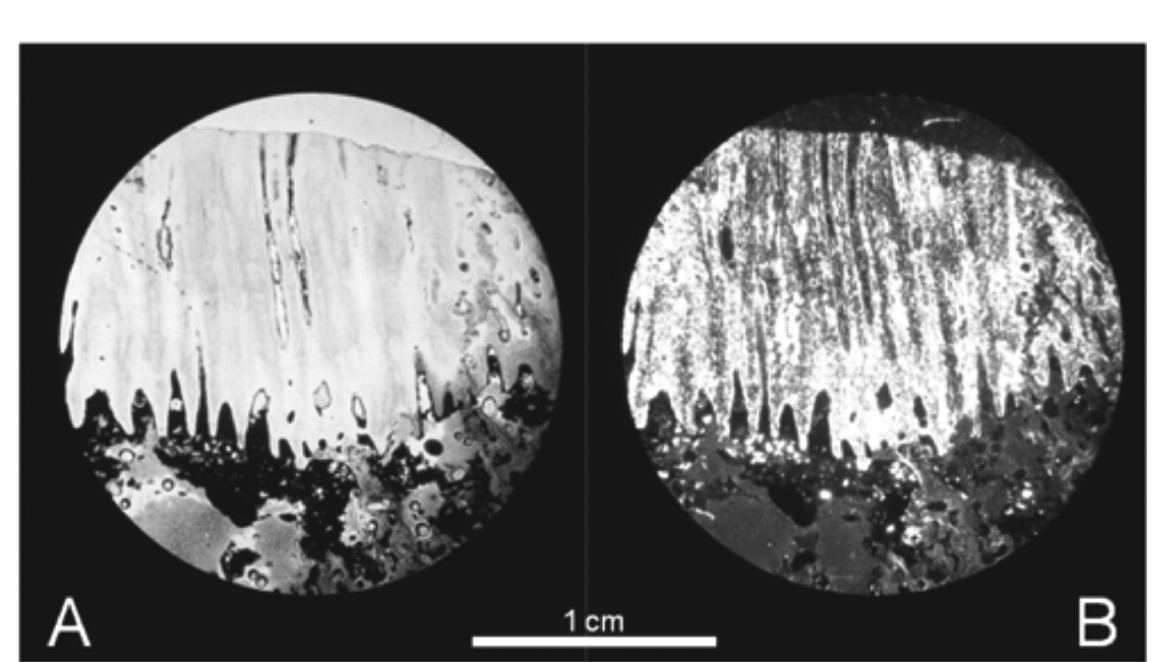
Fig. 5 – Equinoxiodus alcantarensis : Vertical section through the central region of the tooth plate showing the parallel pulpar canals from the pulp chamber to the tritural surface. A) ordinary light. B) polarized